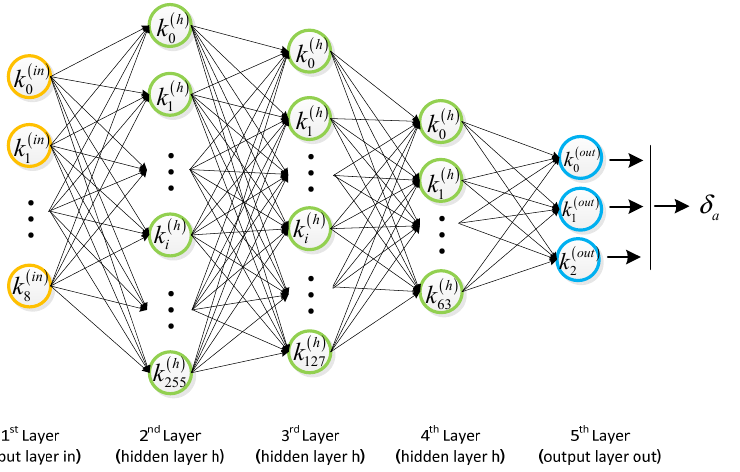
Figure 4. Simulations framework of CDDPG algorithm.